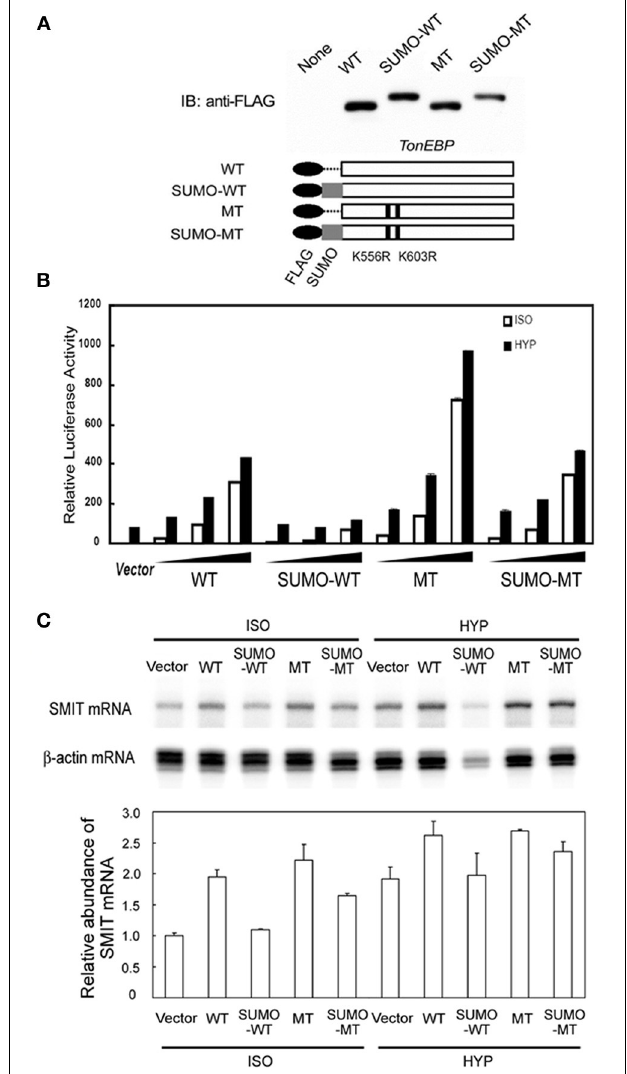
FIGURE 5 | Effects of sumoylation on the transcriptional activity of TonEBP. (A) Schematics of FLAG-tagged TonEBP constructs are shown at bottom: wild type TonEBP (WT), SUMO3-fused TonEBP (SUMO-WT), K556R/K603R mutant TonEBP (MT), or SUMO3-fused MT (SUMO-MT). These constructs were transfected into HEK293 cells and immunoblotted for FLAG (top). (B) HEK293 cells were transfected with empty vector or increasing amounts of the constructs shown in A along with a TonE-driven luciferase reporter, and cultured for 4h in isotonic (ISO) or hypertonic medium (HYP). Expression of luciferase activity is show as in Figure 3 . (C) HEK293 cells were transfected with empty vector or each of the constructs shown in (A) . The cells were cultured for 6h in isotonic (ISO) or hypertonic (HYP) medium. SMIT and β -actin mRNA’s were measured by RPA. The SUMO-WT ( p < 0 . 01) but not from SUMO-MT. Mean + s.e.m., n =